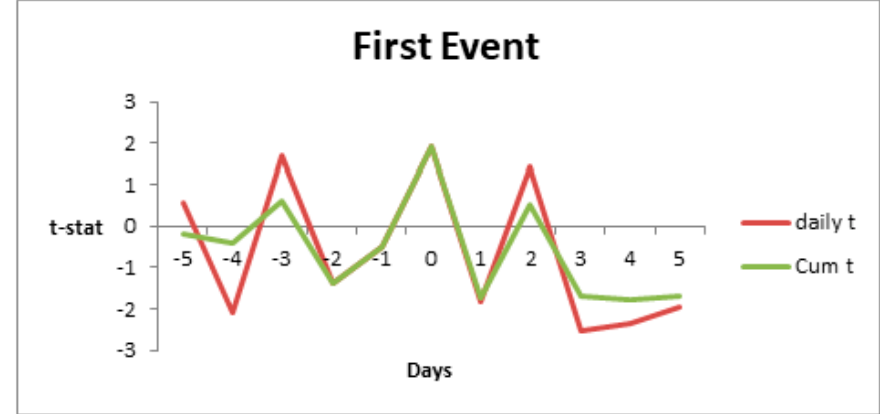
Figure 7. Daily t for AAR and cumulative t for CAAR. Source: Authors’ work.